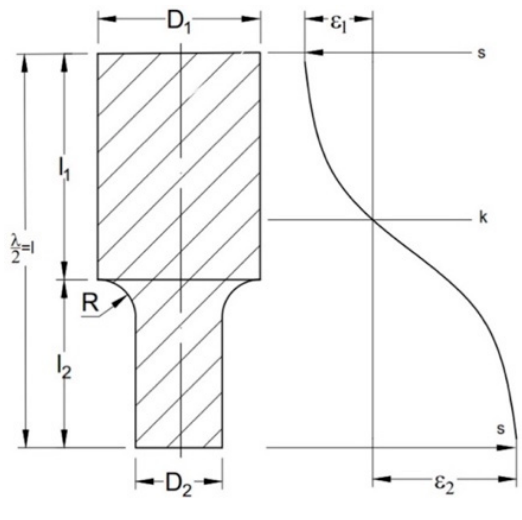
Figure 3. A model of the stepped horn. Table 3. The chemical composition of the SKD11 tool steel (JIS) for fabricating the horn. Component